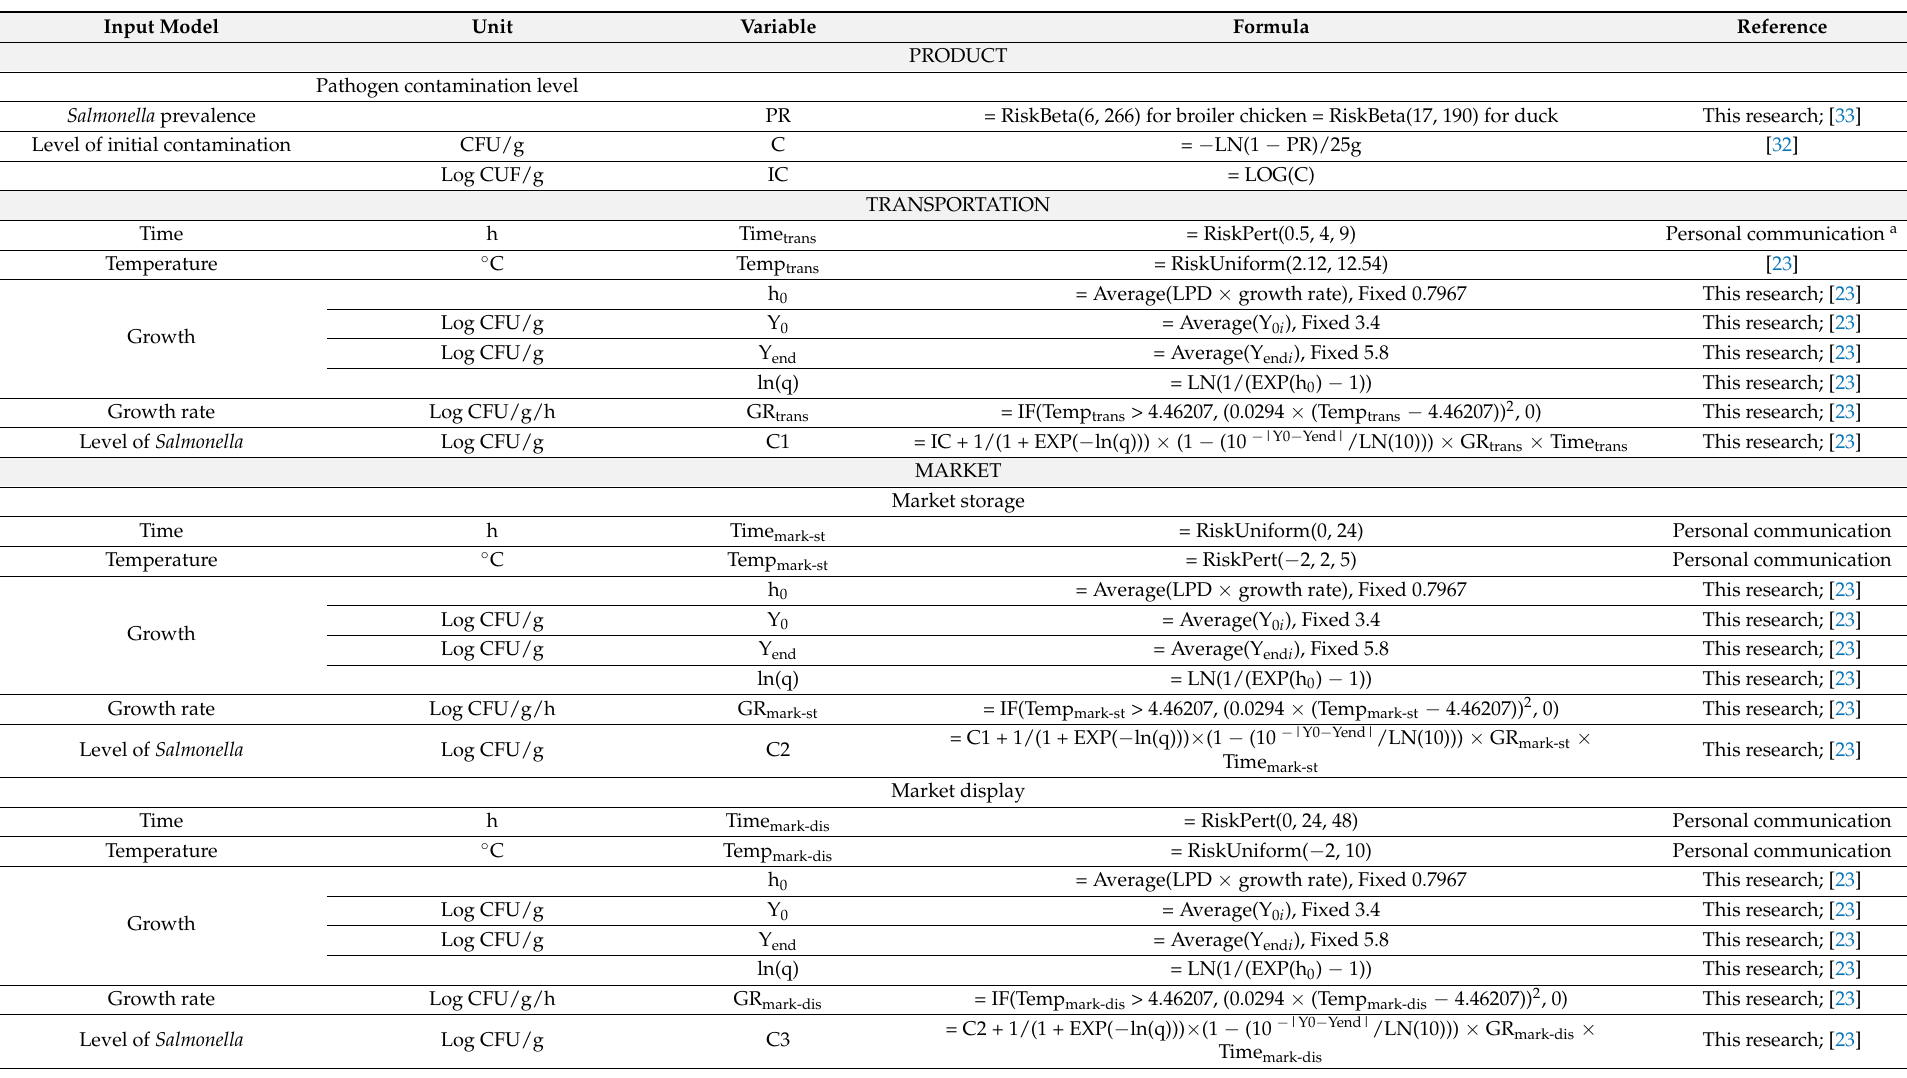
Table 2. @Risk simulation model and formulas used to estimate Salmonella spp. foodborne disease following intake of chicken and duck by cooking